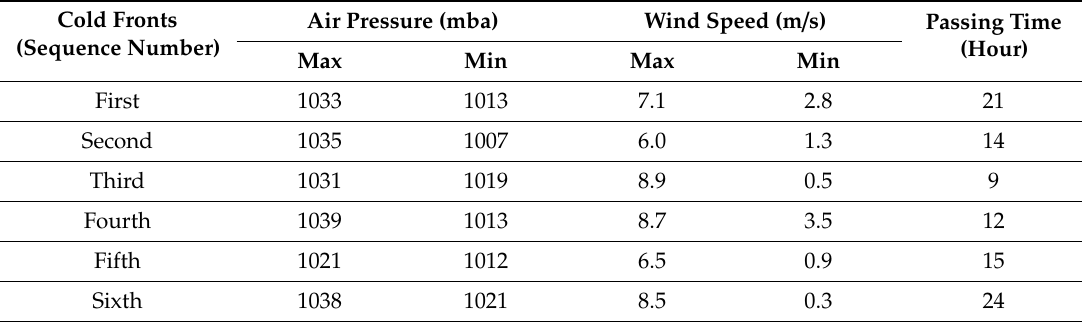
Table 2. Summary of six cold